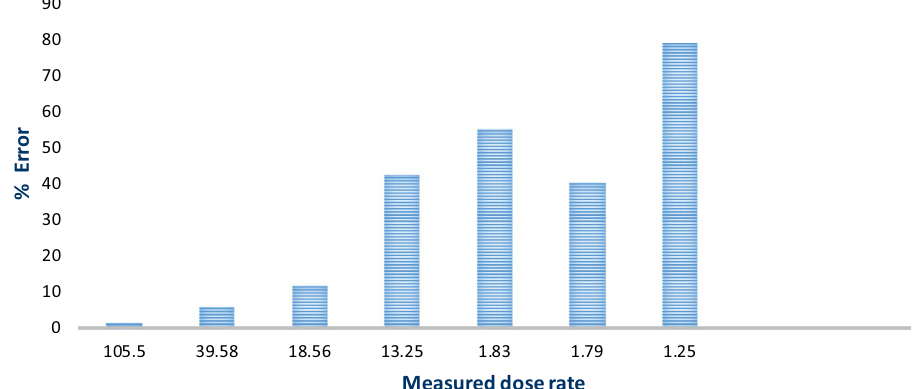
Figure 3. % Error percentage versus measured dose rate (µSv/h).